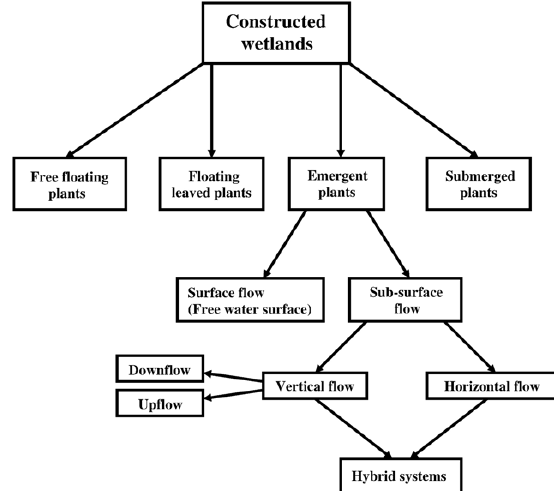
Figure 1. Classificationof constructed wetlands for wastewater treatment (Vymazal, 2001) ,J. Vymazal /Science of the Total Environment 380 (2007) 48–65.